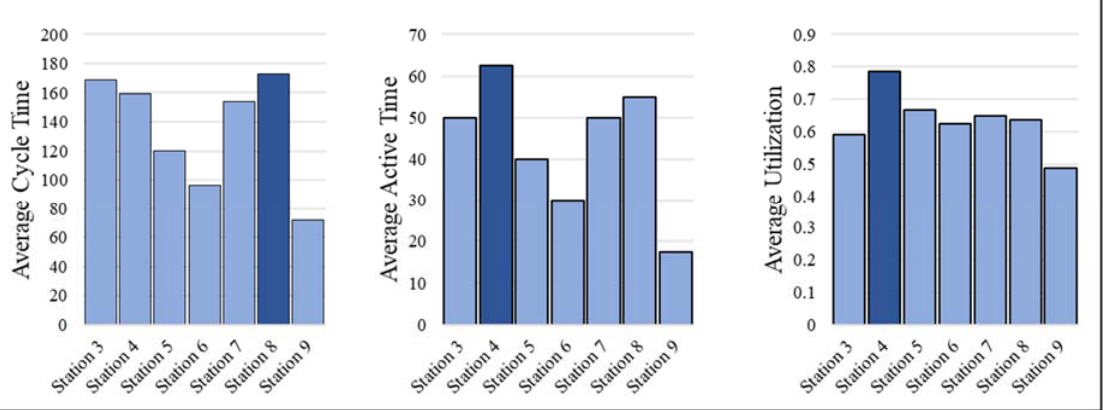
Figure 21. Comparison of metrics extracted using the proposed automated monitoring method.